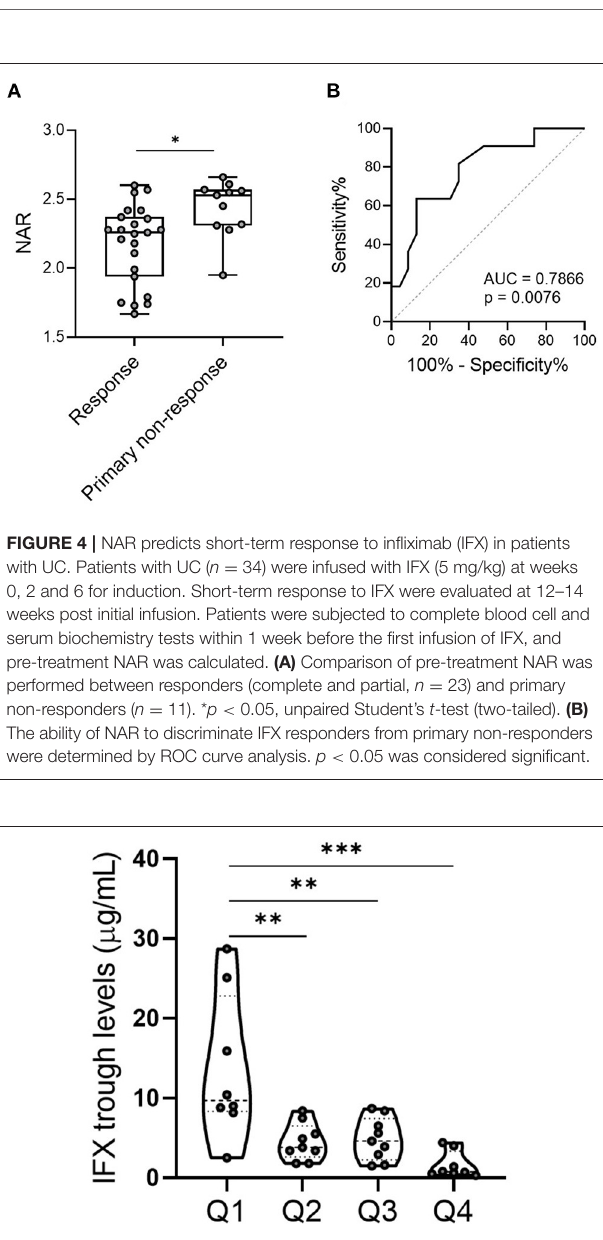
FIGURE 5 | Association between NAR and serum IFX trough level (sIFX TL) in patients with UC. All 34 patients who received IFX induction therapy were grouped by quartiles of NAR. Q1 (quartiles 1, n = 8): 1.67 ≤ NAR < 2.11; Q2 (quartiles 2, n = 9): 2.11 ≤ NAR < 2.31; Q3 (quartiles 3, n = 9): 2.31 ≤ NAR < 2.55; Q4 (quartiles 4, n = 8): 2.55 ≤ NAR. sIFX TL in each group were measured. ** p < 0.01, *** p < 0.001. One-way ANOVA followed by Tukey’s multiple comparisons test was performed and adjusted p -values were